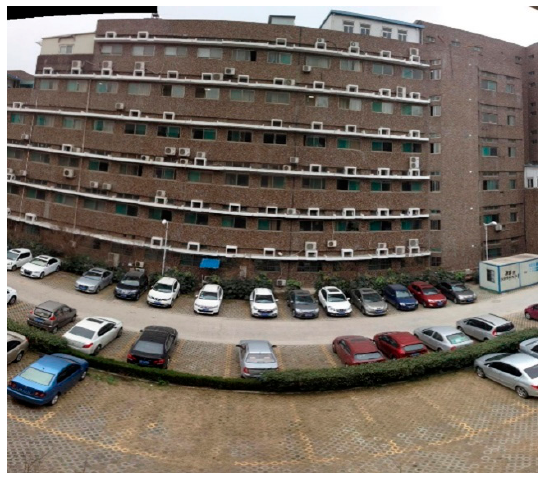
Figure 8. An example of stitched and photometric corrected image obtained with this multi ‐ camera Figure system.